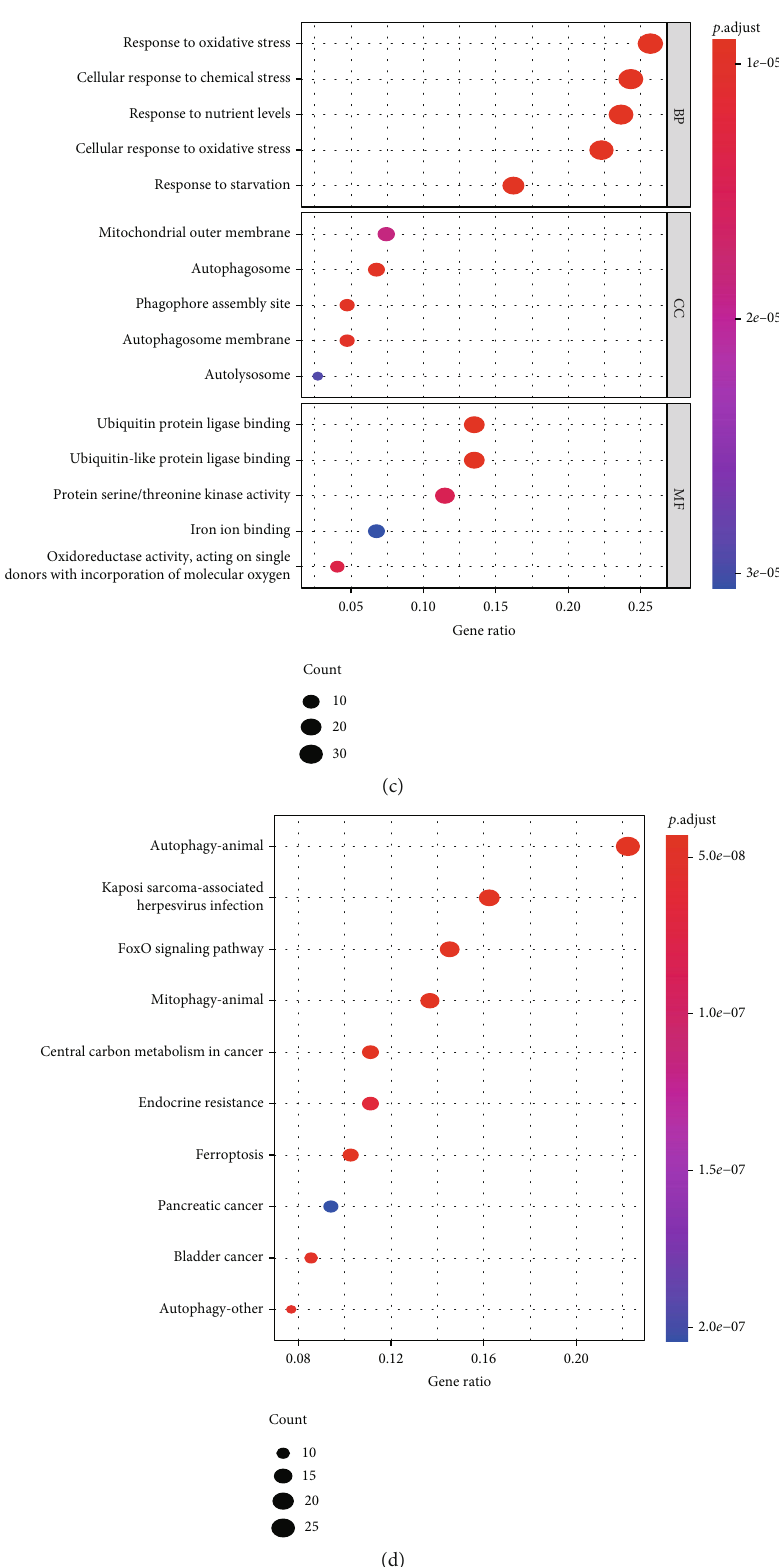
Figure 1: Identi fi cation of DEFRGs and functional annotation. (a) A heatmap to show the expression of DEFRGs in normal and tumor tissues. (b) A volcano plot to show the results of di ff erential analysis. (c) GO enrichment analysis for DEFRGs. BP: biological process; CC: cellular component; MF: molecular function. (d) KEGG pathway enrichment analysis for